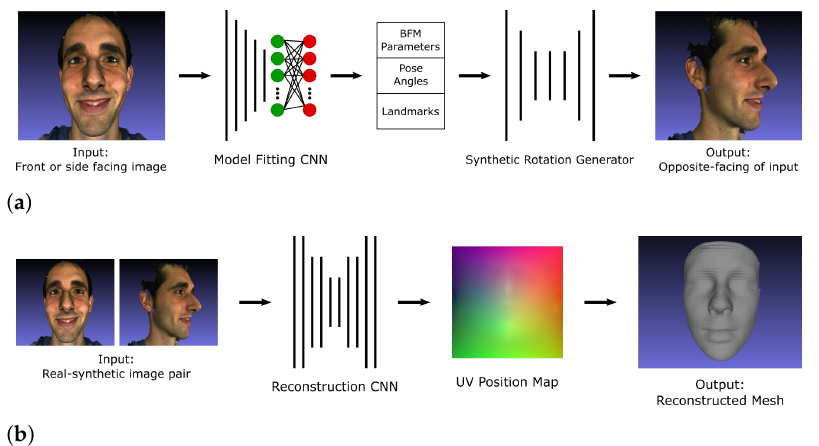
Figure 14. The proposed pipeline for synthetic facial image rotation: ( a ) Synthetic rotation pipeline, from one real facial image input to a synthetically rotated version, ( b ) Reconstruction pipeline from 2-inputs, one real and one synthetically rotated (as in ( a